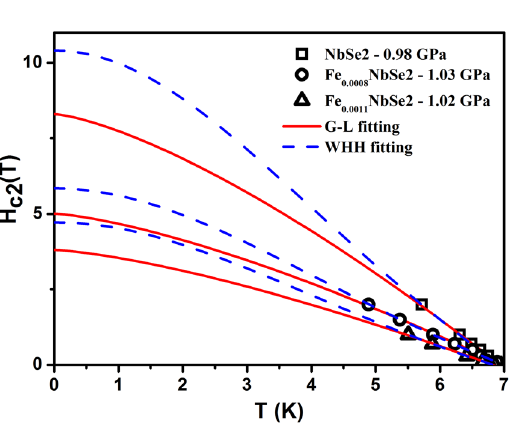
Figure 2. Temperature dependent magnetization measurements of the ( a and b ) NbSe 2 ,( c and d ) Fe 0.0008 NbSe 2 , ( e and f ) Fe 0.0011 NbSe 2 at different magnetic field.